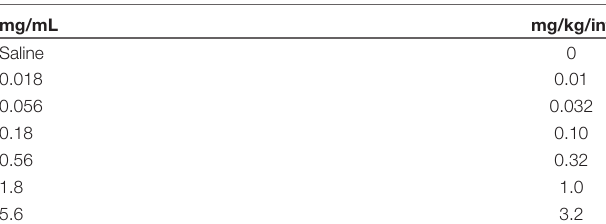
TABLE 5 | Cocaine concentrations used in the current study to achieve the per infusion doses listed.